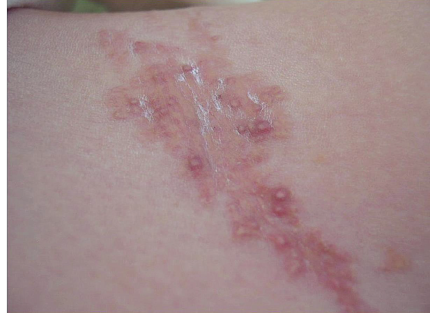
Figure 2: Multiple pinkish, pearly, flesh colored papules.